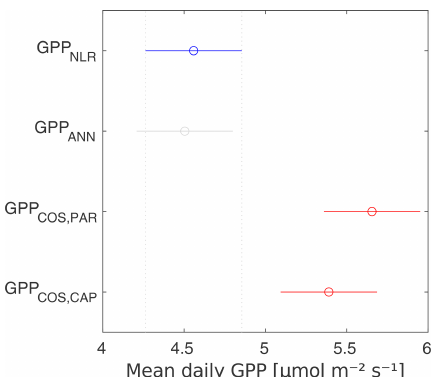
Figure B5. ANOVA test results for daily GPP data. Gray bars indicate no difference to the reference (blue), and red bars indicate statistical difference to the reference. The results show that both GPP COS,PAR and GPP COS,CAP differ statistically from both GPP NLR and GPP ANN at daily scale. GPP COS,PAR and GPP COS,CAP do not differ from each